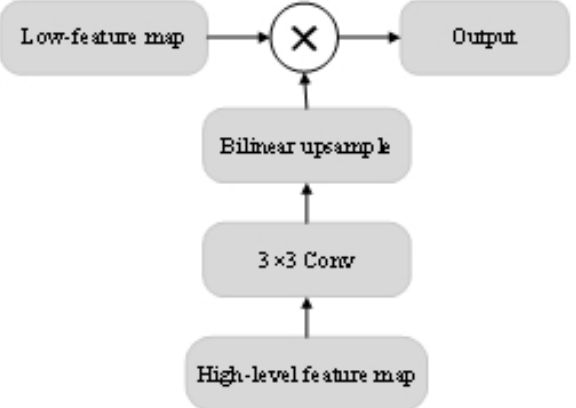
Fig. 4. Structure of semantic embedding feature fusion algorithm.